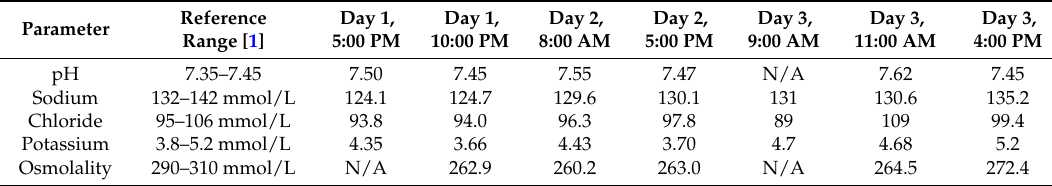
Table 1. Serial bloodwork obtained for fluid therapy